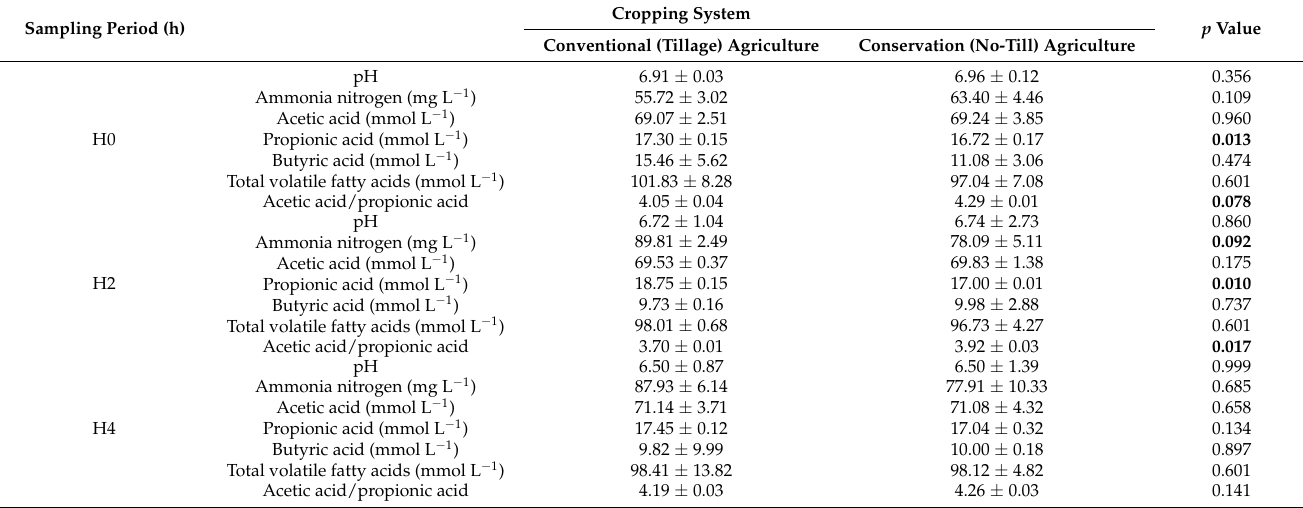
Table 5. Rumen fermentation of ewes grazing on the stubble of wheat grown under conventional tillage and no-tillage cropping